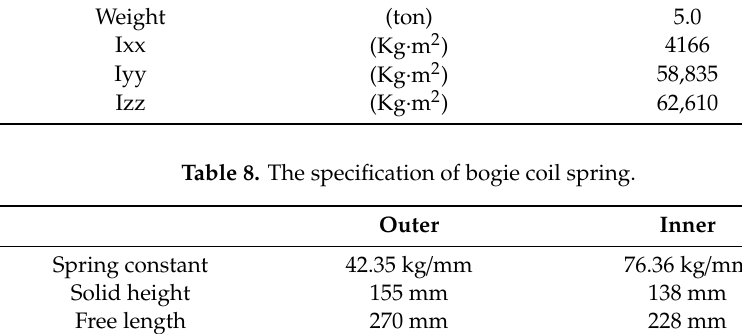
Table 7. The specification of wagon body frame.